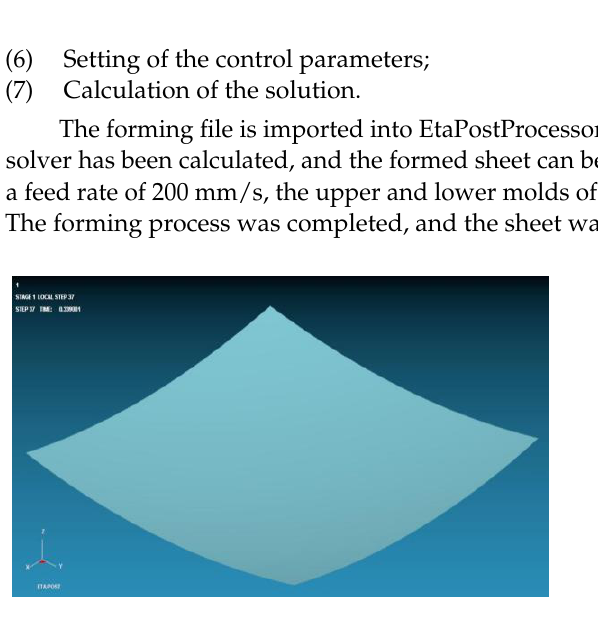
Figure 4. Spherical-part-forming effect.